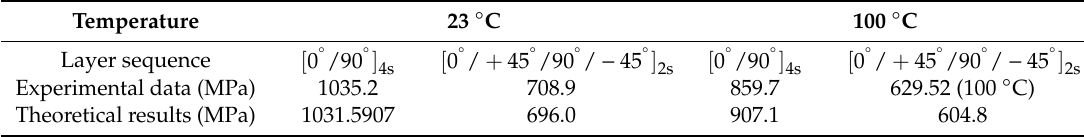
Figure 4. Stress–strain curves of the composite laminates: ( a ) 23 ◦ C; ( b ) 100 ◦ C. Table 3. Finial failure strength comparisons of composite